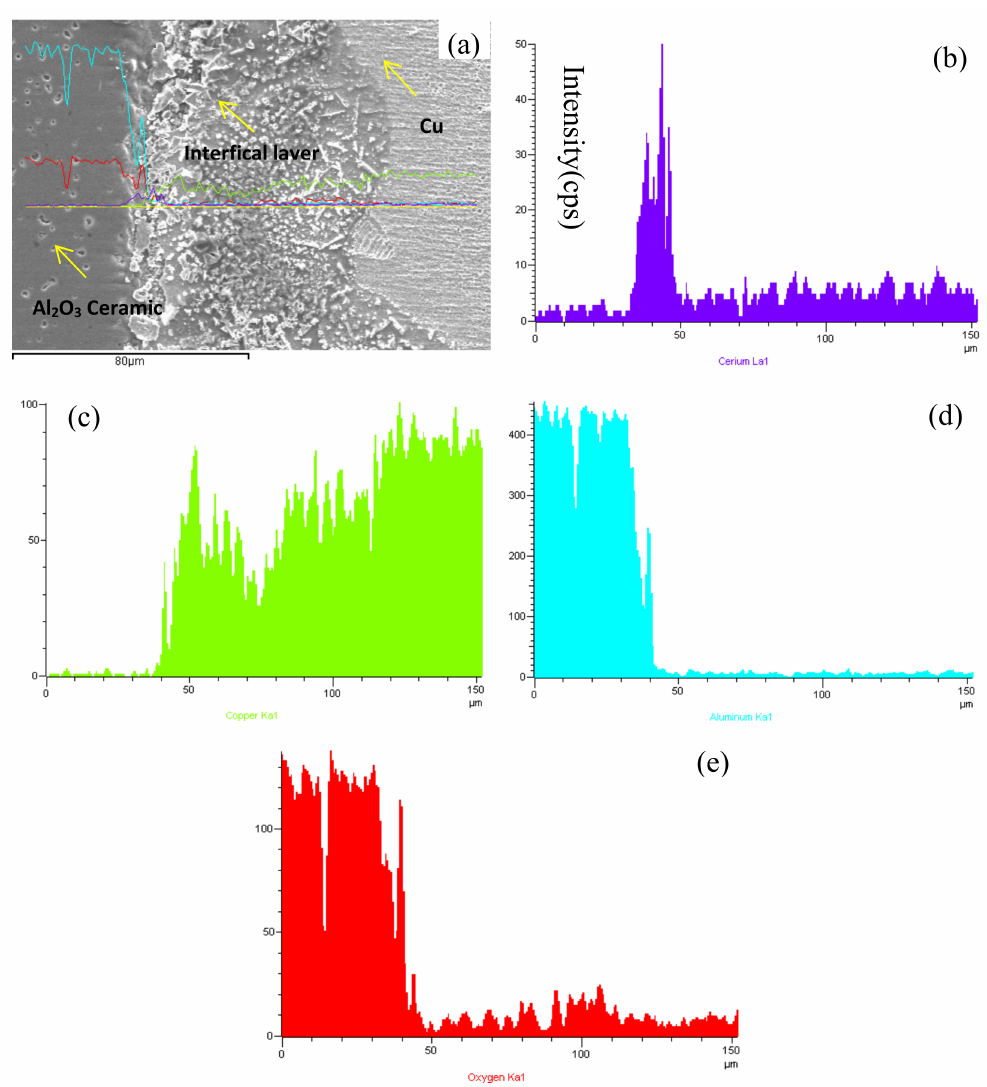
Figure 5. EDS of interface coated with CeO 2 : ( a ) interface, ( b ) Ce, ( c ) Cu, ( d ) Al, ( e )